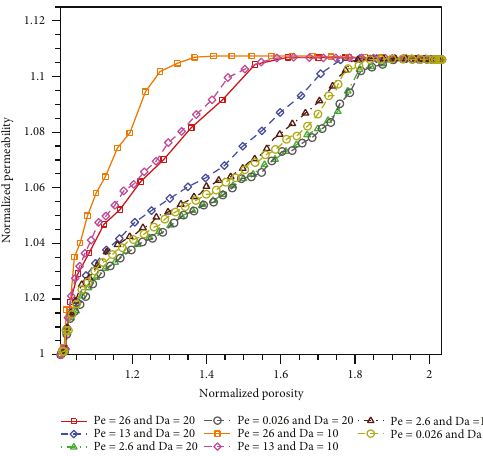
Normalized porosity Pe = 26 and Da = 20 Pe = 0.026 and Da = 20 Pe = 2.6 and Da =10 Pe = 13 and Da = 20 Pe = 26 and Da = 10 Pe = 0.026 and Da = 10 Pe = 2.6 and Da = 20 Pe = 13 and Da = 10 Figure 10: Normalized permeability versus normalized porosity at di ff